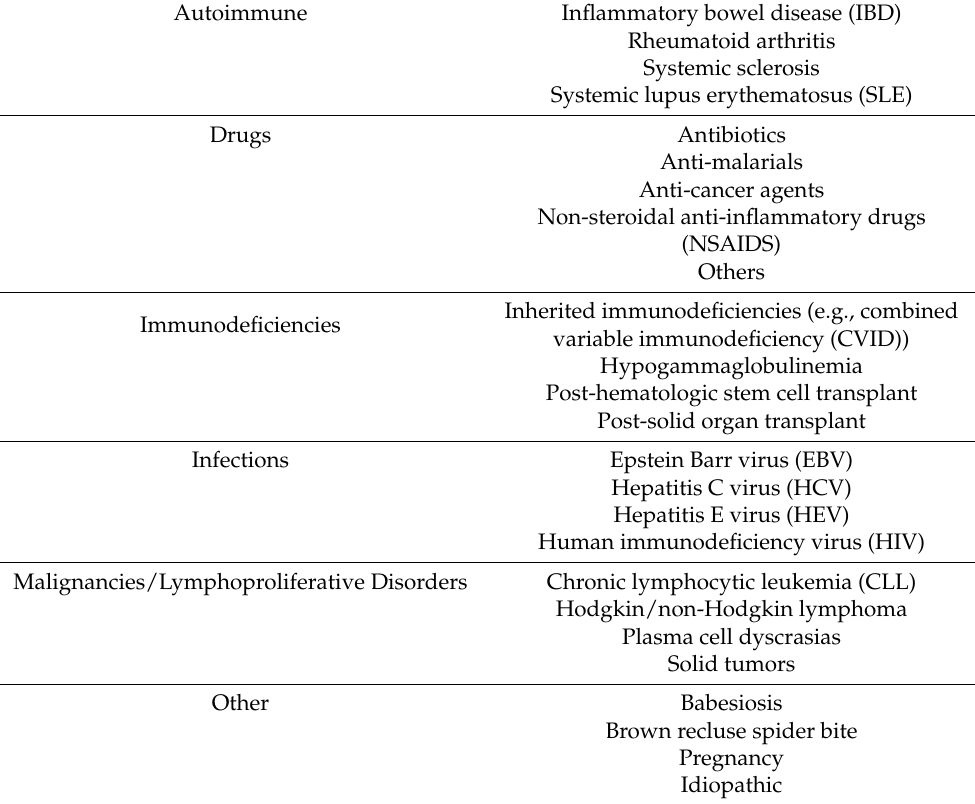
Table 2. Overview of the secondary causes of warm autoimmune hemolytic